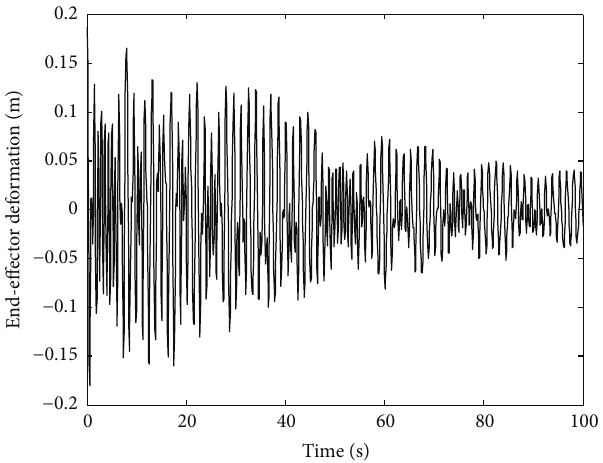
Figure 15: Response of the controlled arm ( 𝑟 = 0 . 35 m).